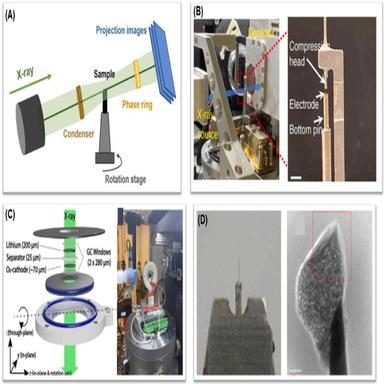
.1. (a) Schematic diagram of the X-ray CT principle; (b) left: experimental setup for the X-ray nano-CT; right: magnified image showing the details of the alignment.; (c) left: a sketch of the cell for operando experiment; right: image of the cell seated and connected to the rotation stage ; (d) left: A SOFC sample inserted in X-ray sample holder; right: X-ray transmission micrograph of the sample.